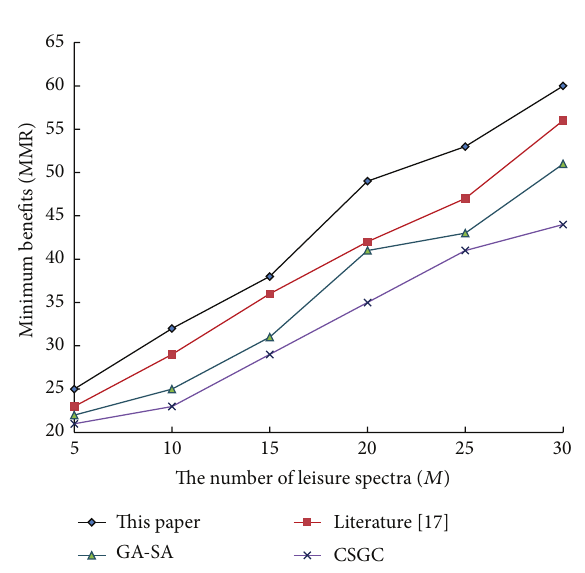
Figure 2: Influence of leisure spectrum on